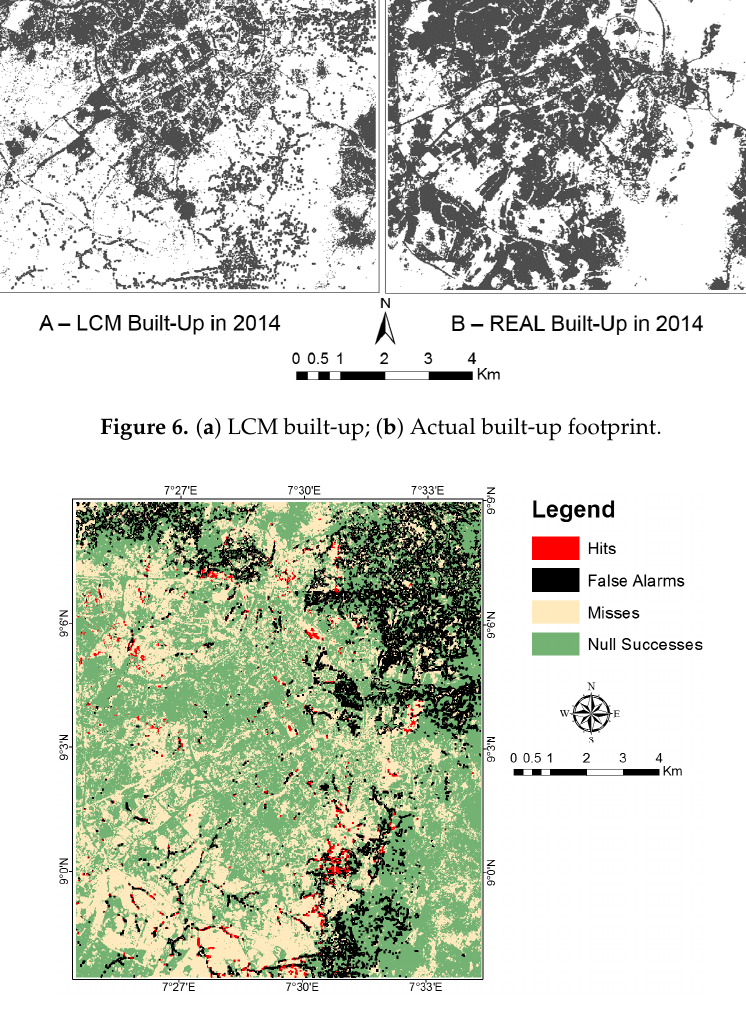
Figure 7. Ocular map validation of correctness using 2001 and 2014 as references and the projected LULC map for 2014.